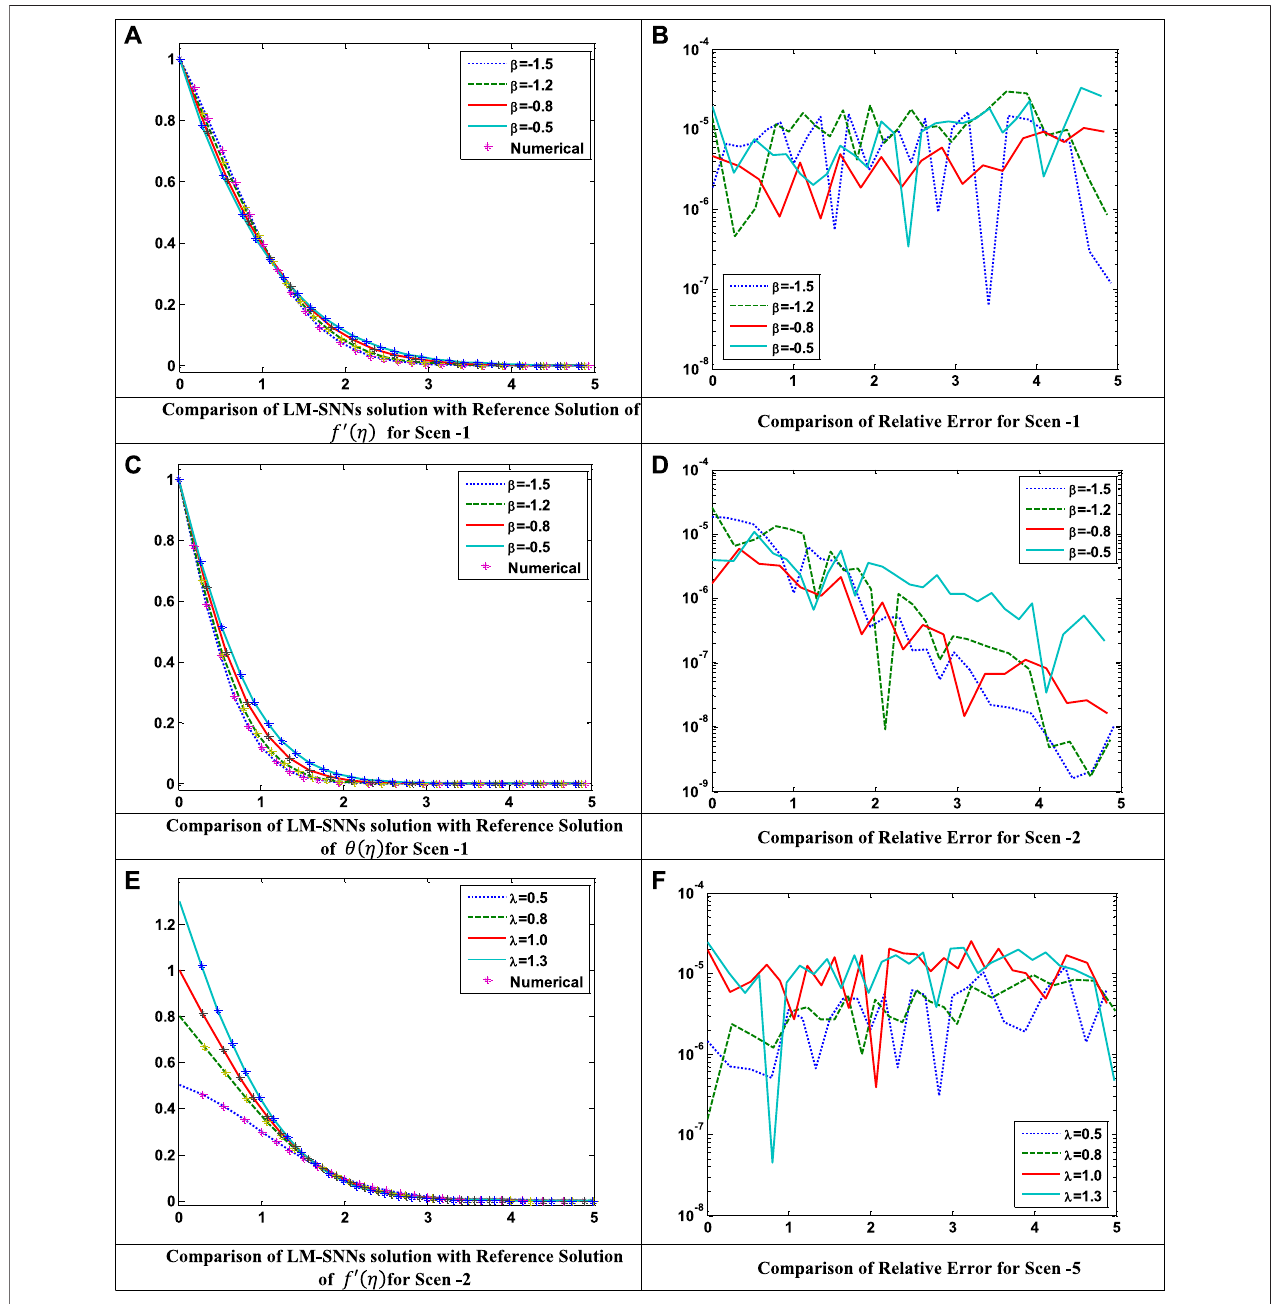
FIGURE 12 | Comparison of the Levenberg – Marquardt supervised neural network solution with reference solution along with relative errors for various scenarios. (a), (b).